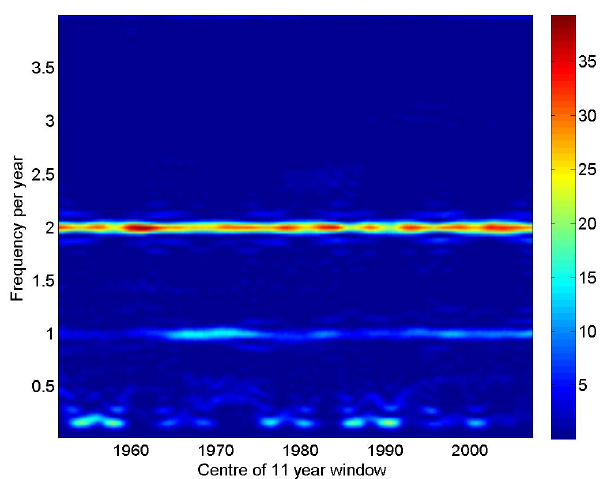
Fig. 3. Lomb–Scargle periodogram for the local noon ionospheric F2 layer above Stanley. The relative power between frequencies is displayed in the colour axis showing a dominant semi-annual vari- ation (frequency per year of 2).